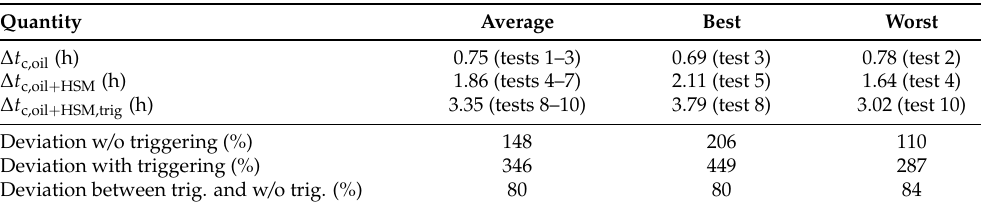
Table 9. Cooling time evaluation of the tests with silicone oil and with silicone oil + HSM (with and without